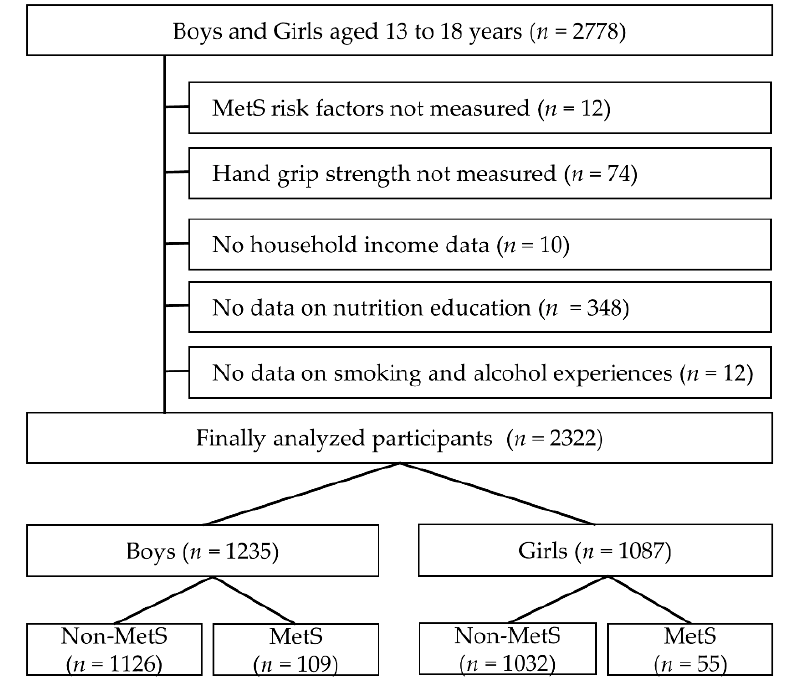
Figure 1. Participant’s inclusion and exclusion process.